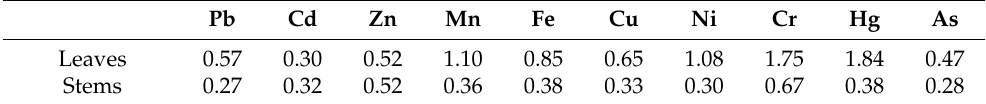
Table 7. Heavy metal translocation from rhizomes to stems and leaves of Ch. majus .